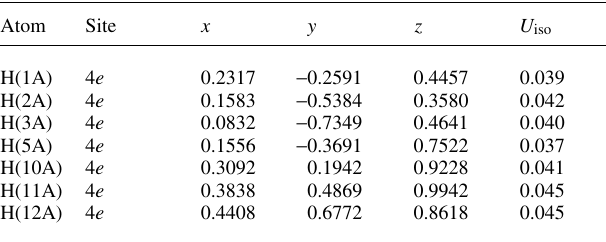
Table 2. Atomic coordinates and displacement parameters (in Å 2 )